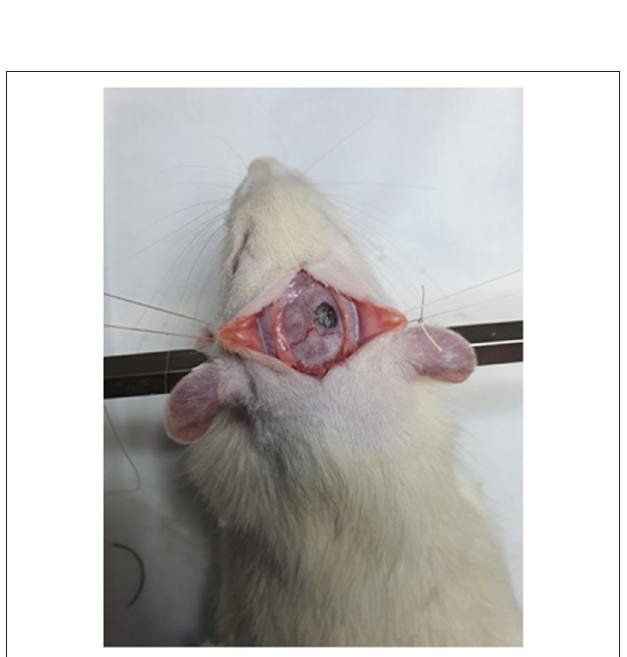
FIGURE 3 | Photograph of drill site for rat neurosurgical model.